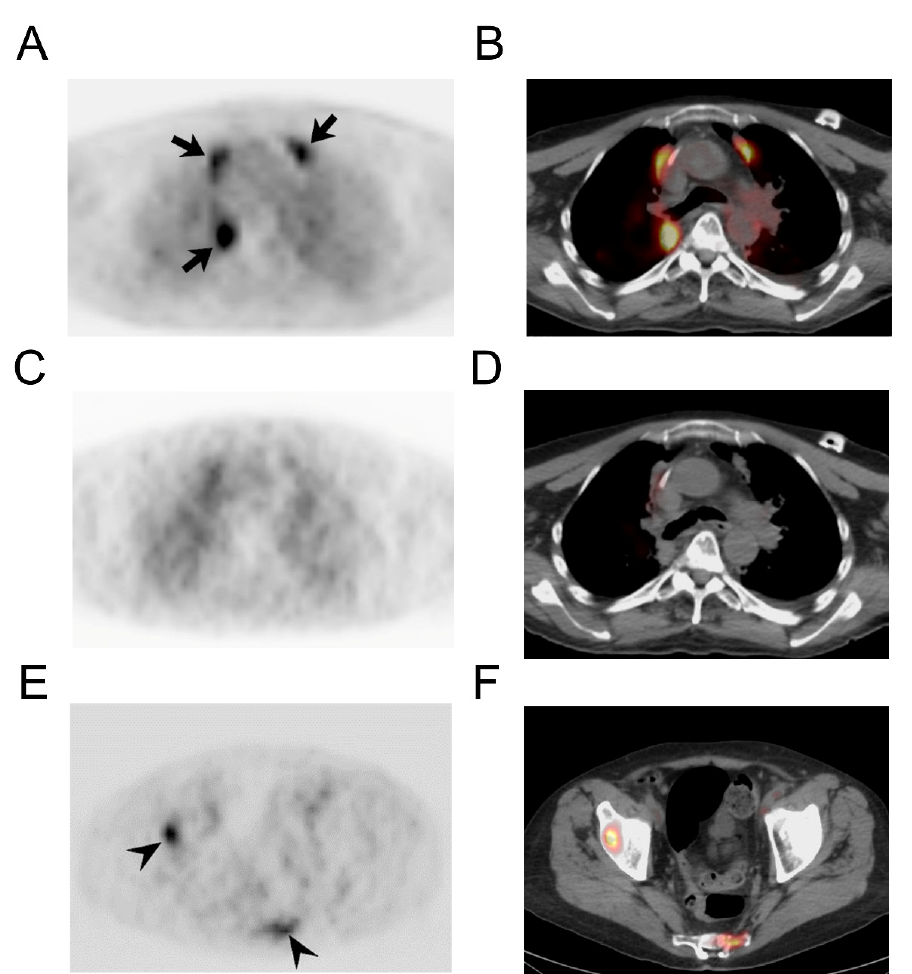
Figure 4. Radiation change and osseous metastatic disease in a 65-year-old man with bronchogenic carcinoma. PET ( A ) and fused PET/CT ( B ) images using [ 18 F]FDG PET shows abnormal linear paramediastinal activity (arrows), characteristic of radiation therapy. Corresponding PET ( C ) and fused PET/CT ( D ) images using [ 124 I]I-NM404 do not show florid uptake in this reactive process. However, [ 124 I]I-NM404 PET did demonstrate multifocal osseous metastatic disease ( E , F ), arrows.